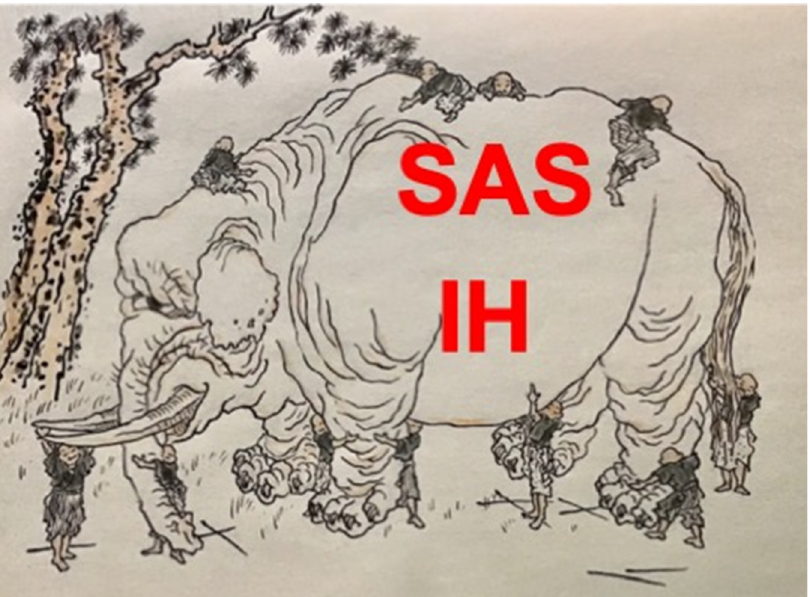
Figure 1. The Blind Men and the Elephant (by Ktsushika Hokusai [1760–1849]) is modified to depict our understanding of SAS and IH. “And so these men of Indostan. Disputed loud and long, Each in his own opinion. Exceeding stiff and strong, Though each was partly in the right. And all were in the wrong!” (“The Blind Men and Elephant” by John Godfrey Saxe [1816–1887]). It may be difficult for us to immediately grasp the essence and the whole picture of SAS and IH, but let us do our best